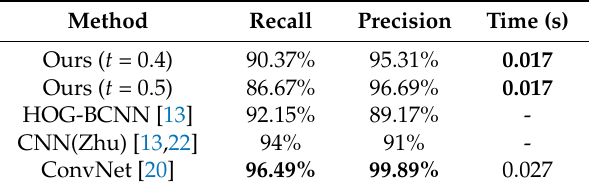
Table 5. The rates of precision and recall for all traffic signs and processing time.